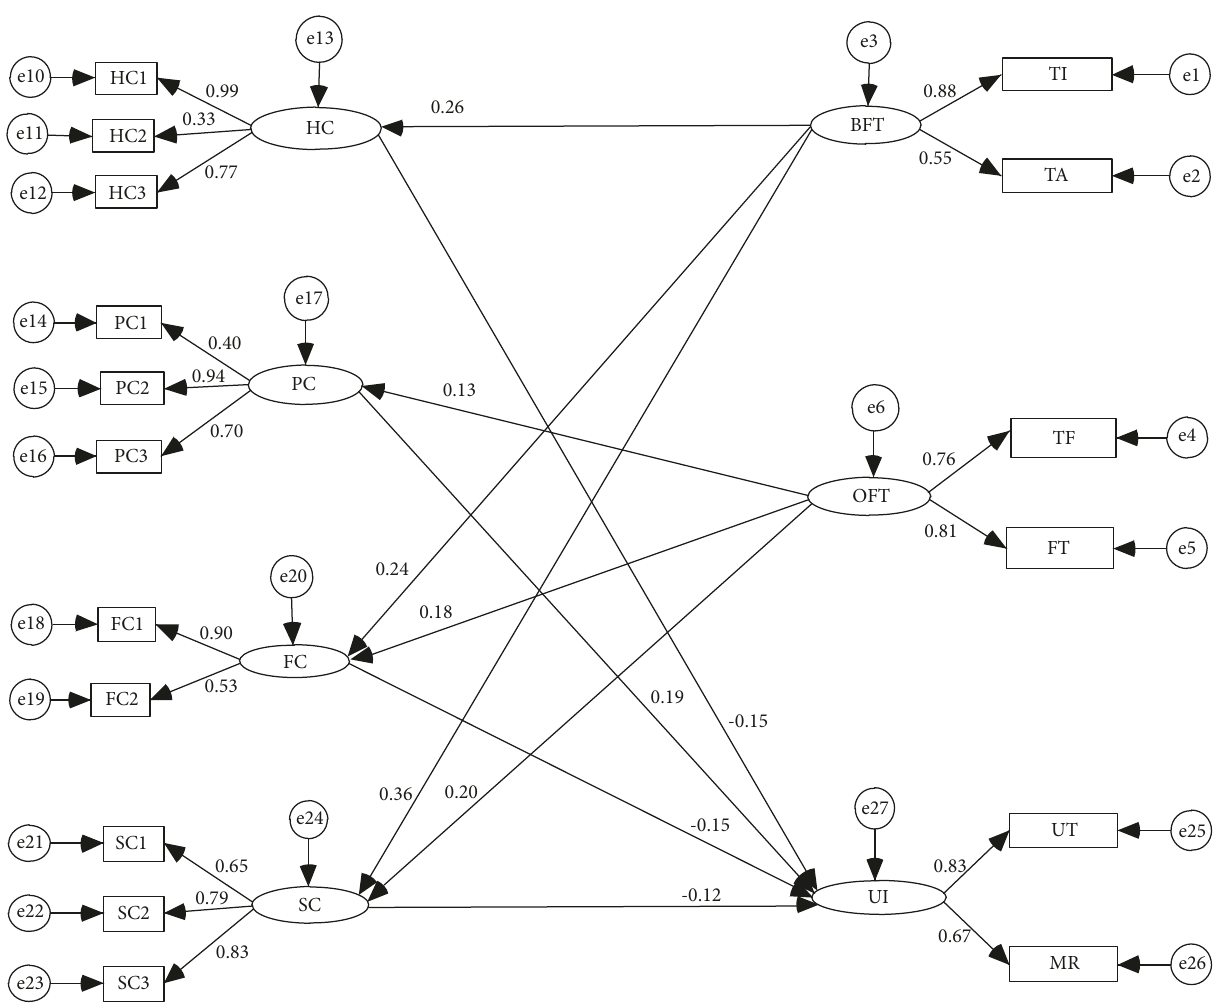
Figure 4: Structural equation model showing the relationships between farmland transfer, livelihood assets, and willingness to urbanism . Abbreviations:BFT, Benefit of farmland transfer; OFT, Openness in farmland transfer; TI, Transfer income; TA, Transfer area; TF, Transferee; FT, Farmland transfer tenure; UI, Willingness to urbanism; UT, Urbanization type; MR, Migration region; HC, Human capital; HC1, Education level; HC2, Labour force; HC3, Health status; PC, Physical capital; PC1, Residential quantity; PC2, Residential quality; PC3, Public transportation;FC,Financialcapital;FC1,Nonagriculturalincome;FC2,Capacitytoborrow;SC,Socialcapital;SC1,Relationshipwithfriends; SC2, Relationship with relatives; SC3, Relationship with village